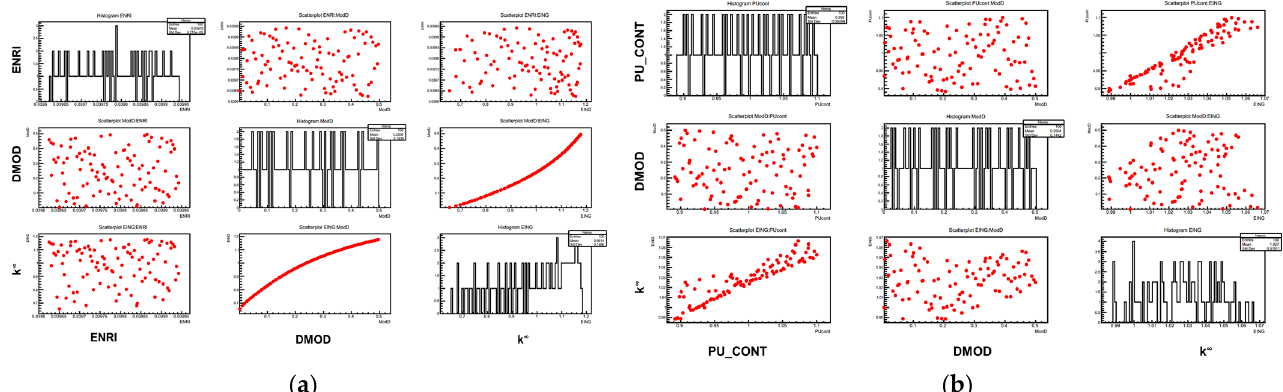
Figure 13. PWR MOX CELL: Pairs plot (CELL_PITCH, BORON).